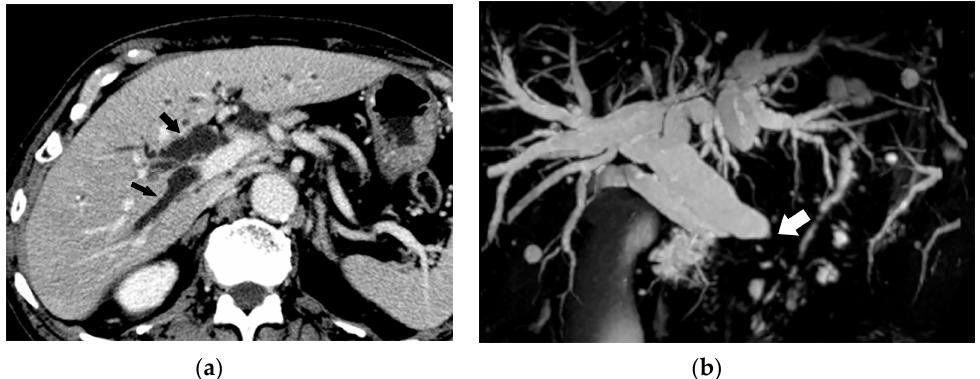
Figure 18. Obstructive jaundice (intra- and extra-hepatic bile duct dilatation) observed in a 77-year- old man. ( a ) In the portal venous phase on contrast-enhanced CT, a dilated linear hypodense structure (arrows) is observed along the portal vein in the hepatic hilar area. ( b ) On MRCP, common bile duct ducts gradually taper as they move toward the peripheral part of the liver.